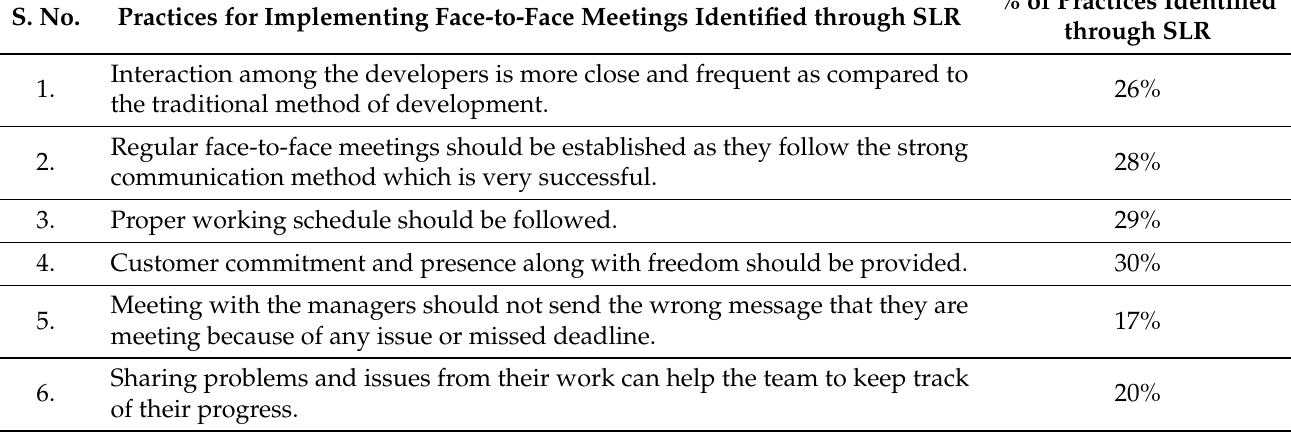
Table 5. Practices for implementing face-to-face